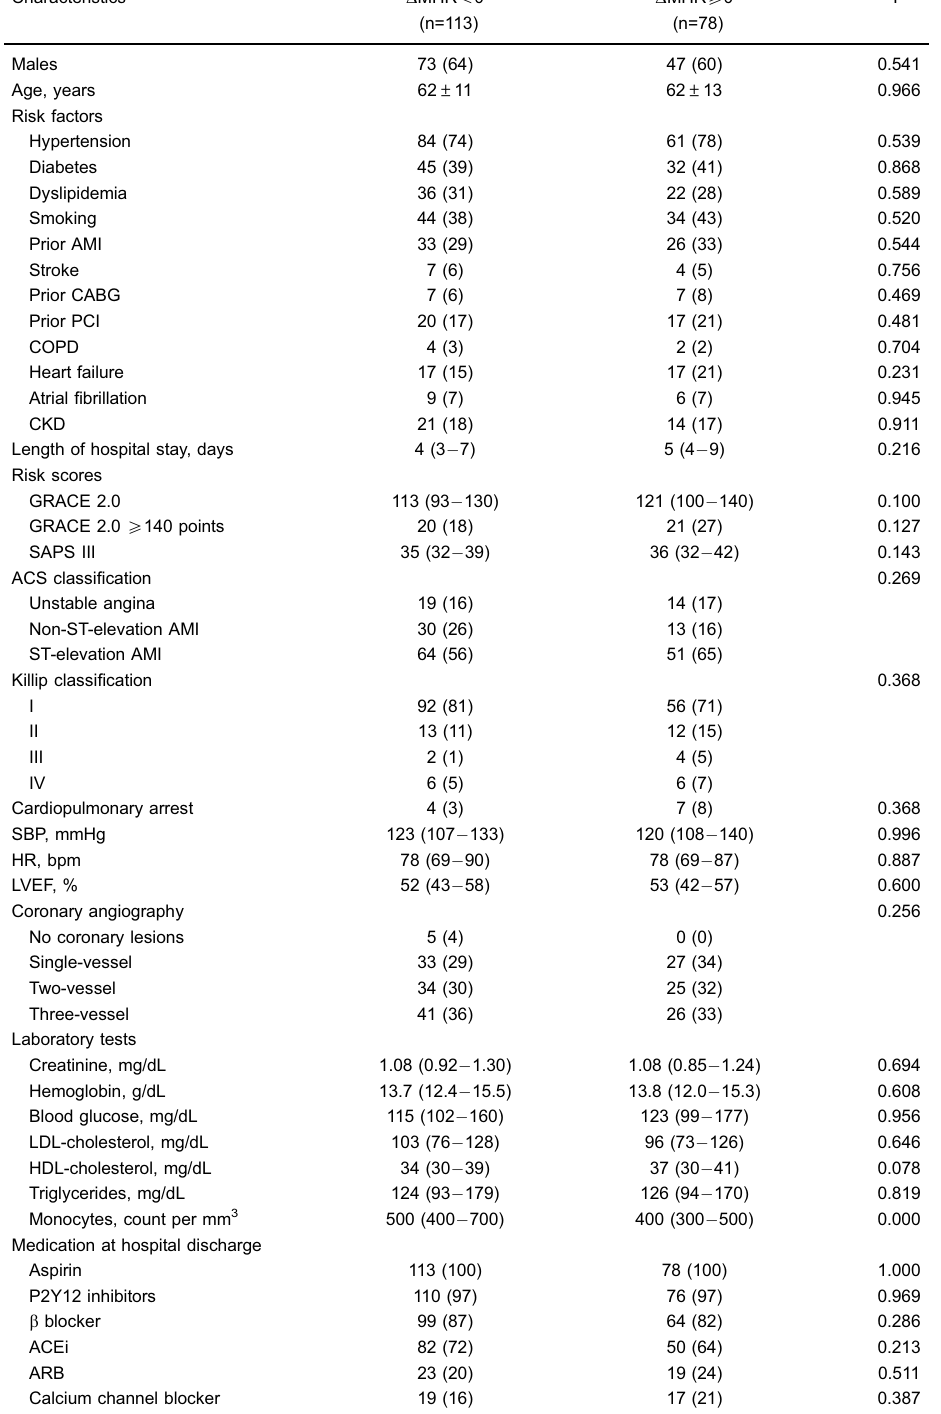
Table 1. Baseline characteristics of the patients according to the D